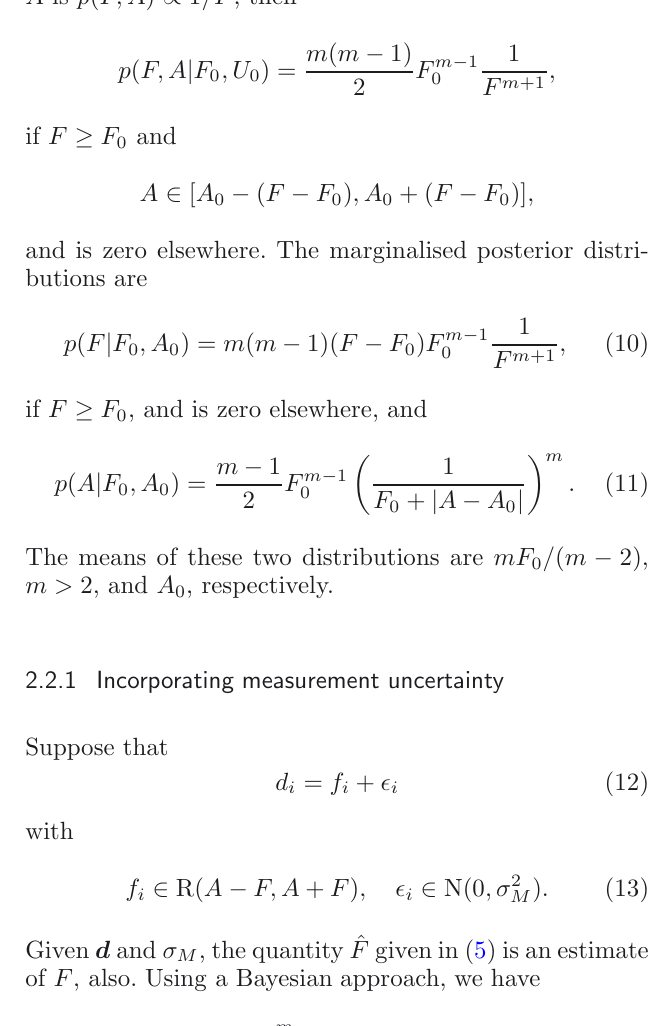
of this distribution is 0 . 0112